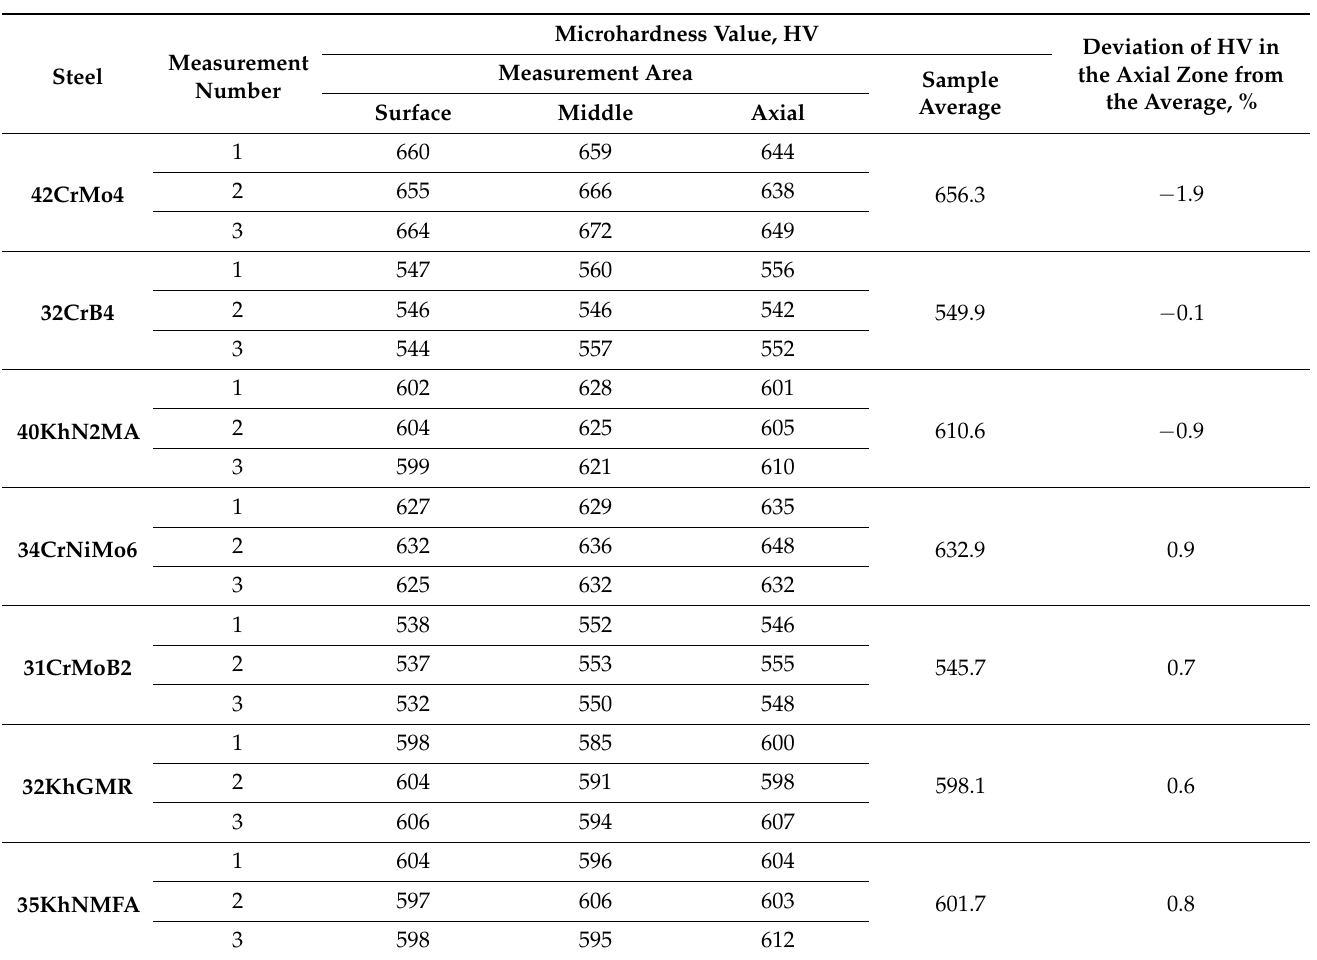
Table 3. Results of measurement of Vickers microhardness on samples of hot-rolled studied steel after